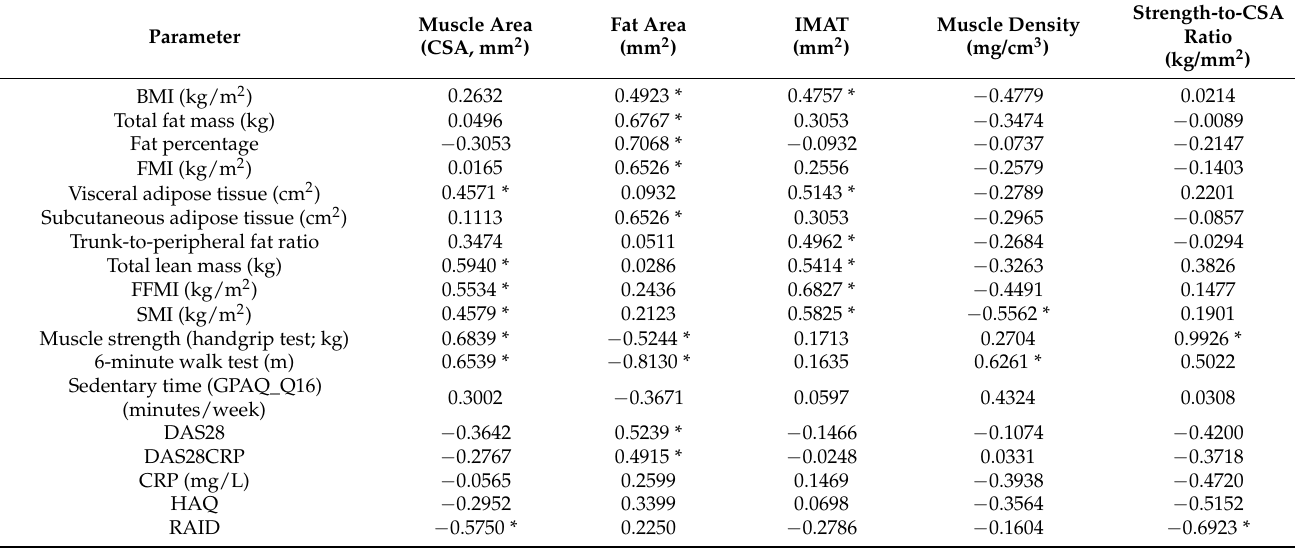
Table 3. Associations in RA between muscle parameters measured with pQCT, total body composition parameters measured with DXA, muscle function, and disease characteristics.